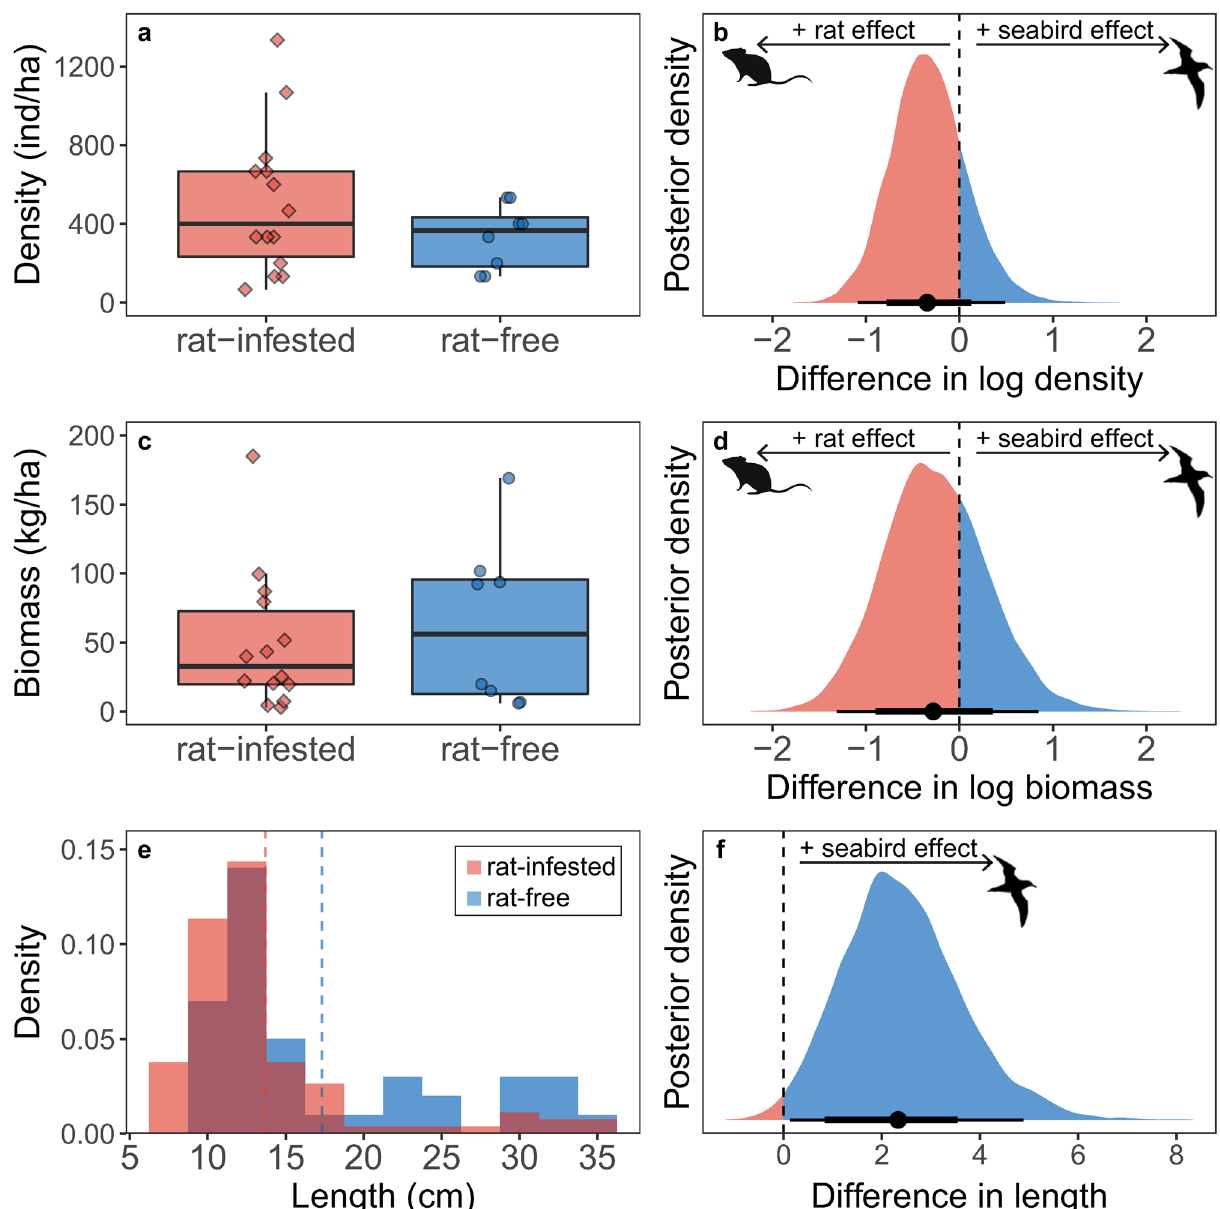
Figure 2. Density, biomass, and size frequency distribution of all Chlorurus sordidus around rat-free islands with abundant seabirds (blue, circles) compared to rat-infested islands with few seabirds (red, diamonds). ( a , c ) Box limits represent first and third quantiles (25% and 75% percentiles), middle line represents the median (50% percentile), and whiskers represent smallest and largest observations less than or equal to 1.5 × inter-quartile range. Each point represents one transect. Transects on which no C. sordidus were observed were excluded from the boxplots (n = 10 around rat-infested islands, n = 12 around rat-free islands) to correspond to estimates from non-zero components of hurdle gamma models presented in ( b , d ). ( e ) Size frequency distribution of C. sordidus in 2.5 cm size bins. ( b , d , f ) Bayesian posterior densities for the effect of seabird presence on corresponding responses in ( a , c , e ). Positive values of the posterior distributions (blue fill) indicate a positive effect of seabird presence on the response, negative values (red fill) indicate a negative effect of seabirds (i.e., positive effect of invasive rat presence). Points represent median highest posterior density estimate and lines represent 75% and 95% highest posterior distribution intervals (HPDI). Rat and seabird silhouettes were obtained from phylopic. org under Public Domain Dedication 1.0